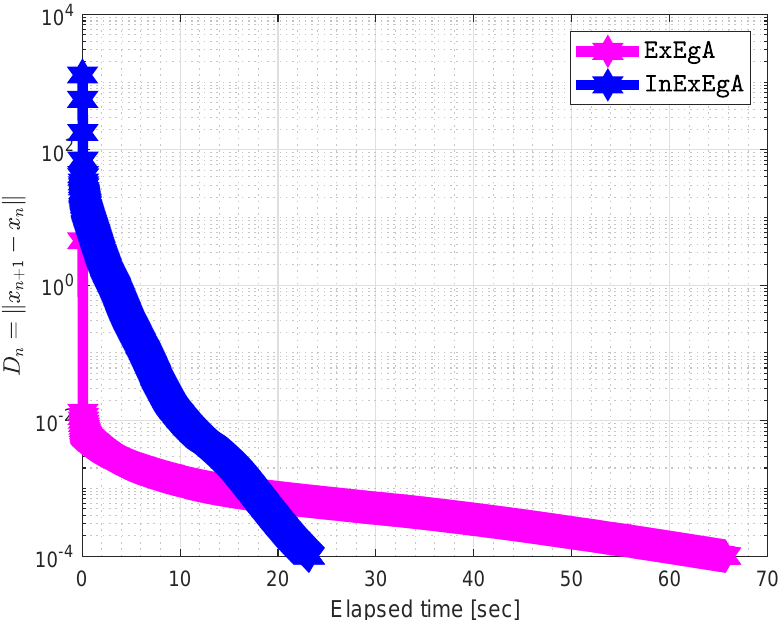
Figure 12. Algorithm 1 comparison with Algorithm 1 in [16] when m =